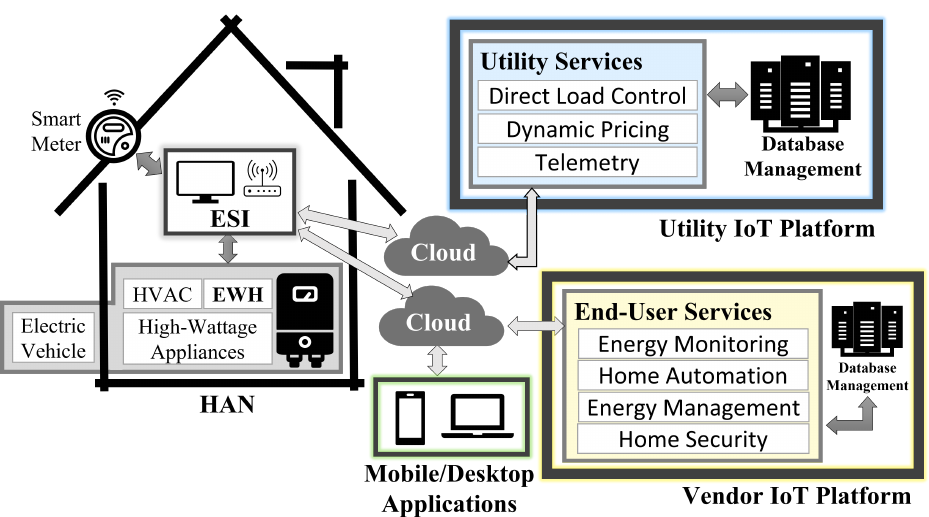
Figure 1. IoT-enabled DSM and smart home